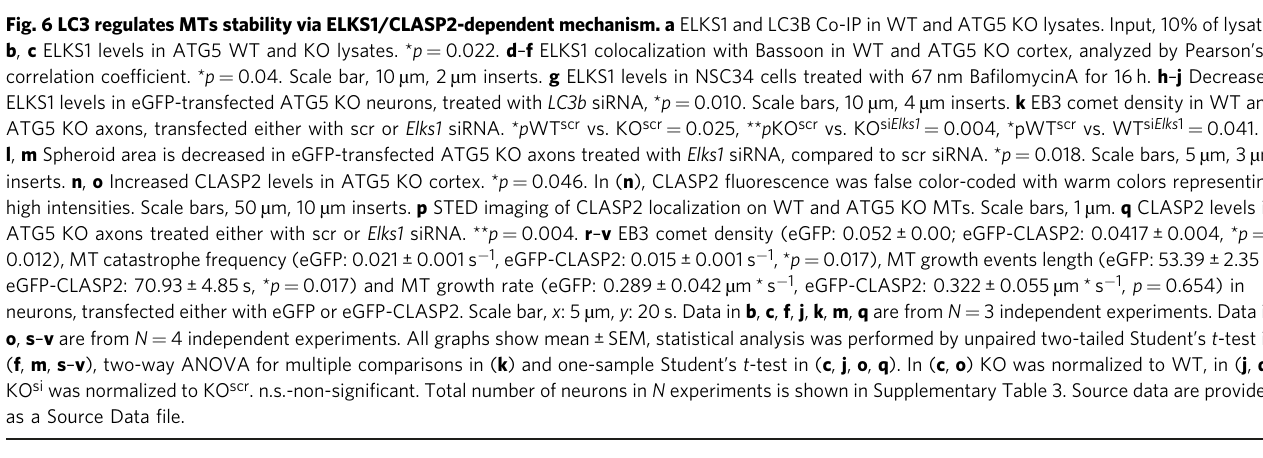
Fig. 6 LC3 regulates MTs stability via ELKS1/CLASP2-dependent mechanism. a ELKS1 and LC3B Co-IP in WT and ATG5 KO lysates. Input, 10% of lysate. b , c ELKS1 levels in ATG5 WT and KO lysates. * p = 0.022. d – f ELKS1 colocalization with Bassoon in WT and ATG5 KO cortex, analyzed by Pearson ’ s correlation coef fi cient. * p = 0.04. Scale bar, 10 µ m, 2 µ m inserts. g ELKS1 levels in NSC34 cells treated with 67 nm Ba fi lomycinA for 16 h. h – j Decreased ELKS1 levels in eGFP-transfected ATG5 KO neurons, treated with LC3b siRNA, * p = 0.010. Scale bars, 10 µ m, 4 µ m inserts. k EB3 comet density in WT and ATG5 KO axons, transfected either with scr or Elks1 siRNA. * p WT scr vs. KO scr = 0.025, ** p KO scr vs. KO si Elks1 = 0.004, *pWT scr vs. WT si Elks 1 = 0.041. l , m Spheroid area is decreased in eGFP-transfected ATG5 KO axons treated with Elks1 siRNA, compared to scr siRNA. * p = 0.018. Scale bars, 5 µ m, 3 µ